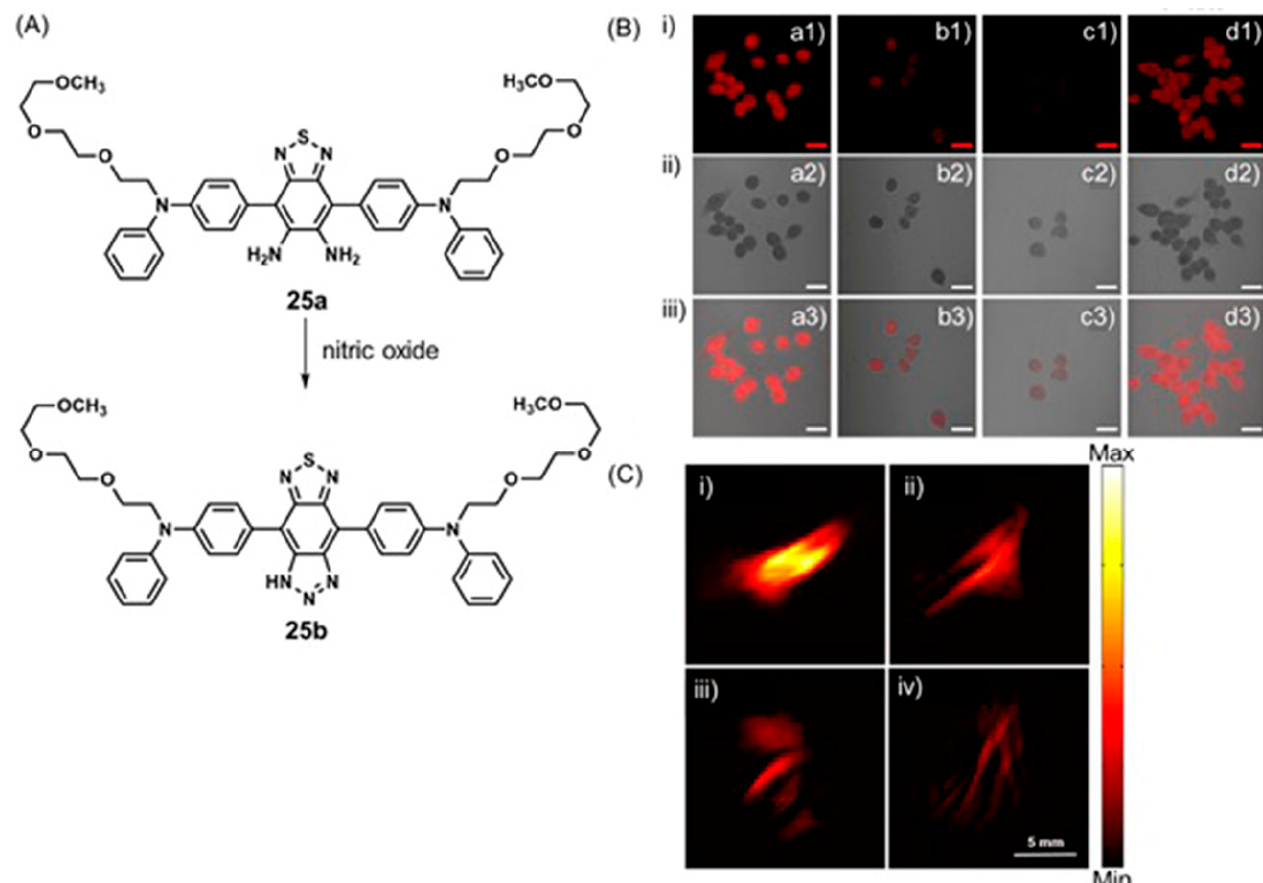
Figure 48. ( A ) Transformation of 25a to 25b in the presence of nitric oxide. ( B ) Confocal fluorescence images for detection of nitric oxide in RAW264.7 cells. (1), (2), and (3) represent the red channel, bright field, and merged images, respectively. Columns left to right represent (a) Cells incubated with the probe (2 μ M) for 1 h. (b) and (c) The cells were pretreated with 2 and 5 μ g mL –1 lipopoly- saccharide, respectively, to induce inflammation for 4 h and then incubated with the probe (2 μ M) for another 4 h. d) Cells were pretreated with N -acetylcystein (2 mM) to inhibit nitric oxide for 1 h, incubated with lipopolysaccharide (5 μ g/mL) for 4 h, and then incubated with the probe (2 μ M) for 4 h. Merged images were produced by combining the red channel and bright field. Excitation wave- length = 405 nm; emission wavelength = 500–600 nm. Scale bars = 20 μ m. ( C ) In vivo photoacoustic images of subcutaneously injected seven-week-old mice (I) and (II) induce inflammation by lipo- polysaccharide (200 μ L, 1 mg mL –1 ). (III) and (IV) injected with phosphate-buffered saline (200 μ L, pH 7.4) as reference sites. (I) and (III) represent images acquired from the sites also subcutaneously injected with probe (150 μ L, 10 μ M). Adapted from Sensors and Acutators B: Chemical , 267 , Wang, S.; Li, Z.; Liu, Y.; Feng, G.; Zheng, J.; Yuan, Z.; Zhang, X. Activatable photoacoustic and fluorescent probe of nitric oxide for cellular and in vivo imaging, 403–411, Copyright 2018, with permission from Elsevier [361].